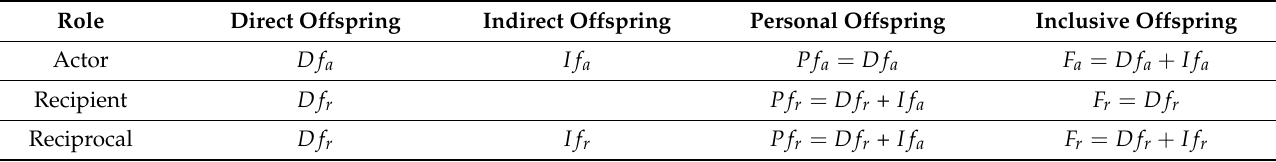
Table 2. Abbreviations of magnitudes for interactions.